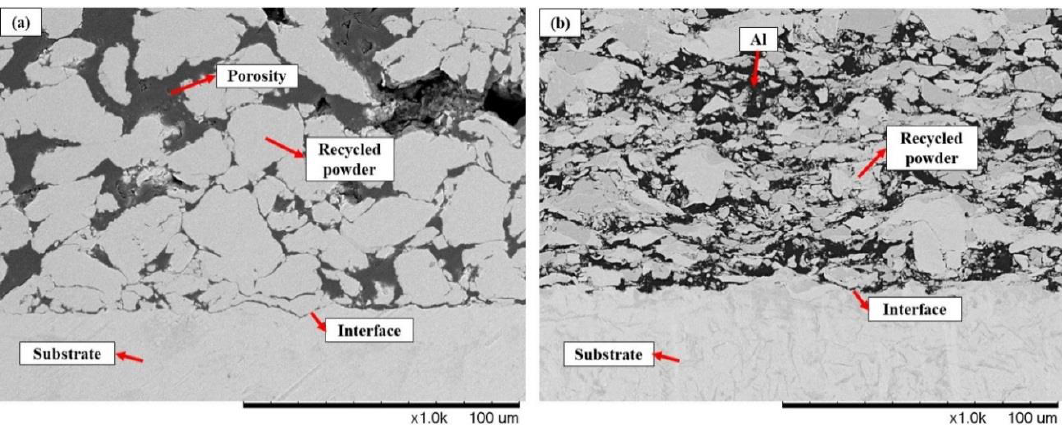
Figure 7. SEM micrographs of cold spray deposits produced by utilization of ( a ) He and ( b ) air as process gases (deposition parameters are listed in Table 3).